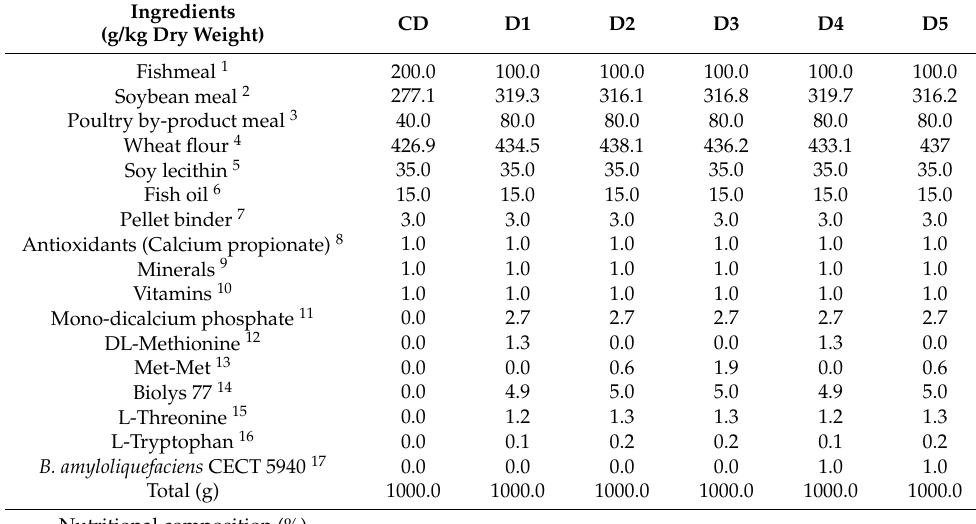
Table 1. Ingredients and proximate composition of the experimental diets (g/kg dry